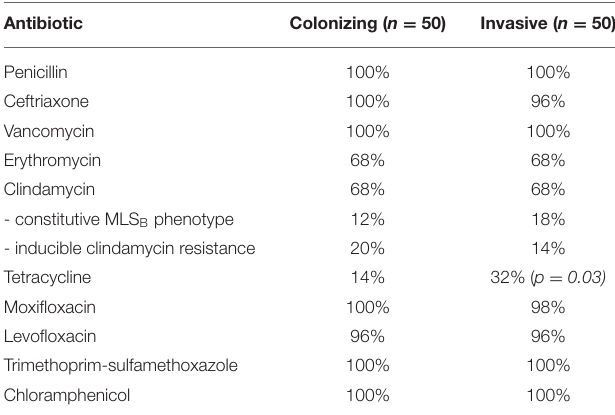
TABLE 4 | Phenotypic antibiotic susceptibility profiles of GBS isolates, as tested by Vitek r 2 AST-ST03.